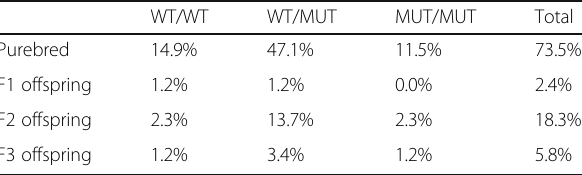
Table 1 Distribution of study dogs based on breed status and